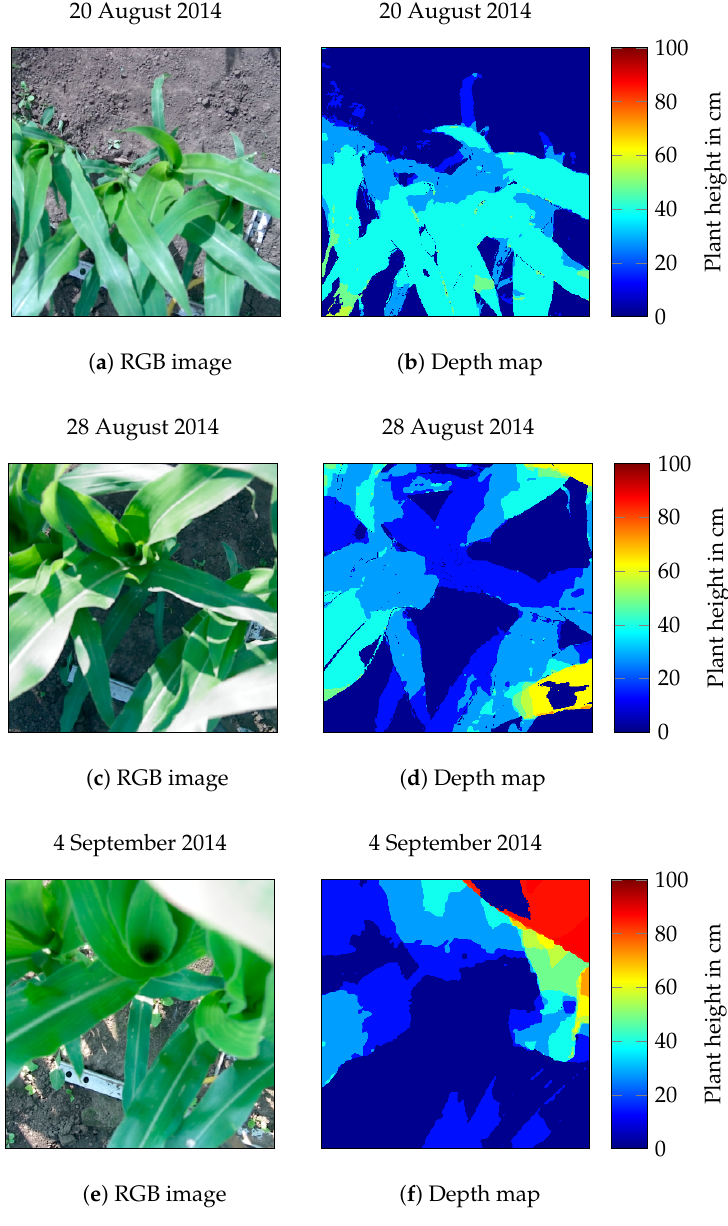
Figure 14. ( a – f ) RGB images on the left ( a , c , e ) show exemplary dates during the field campaign compared to the corresponding depth maps allowing the approximation of plant height and morphological traits represented in the images on the right ( b , d , f